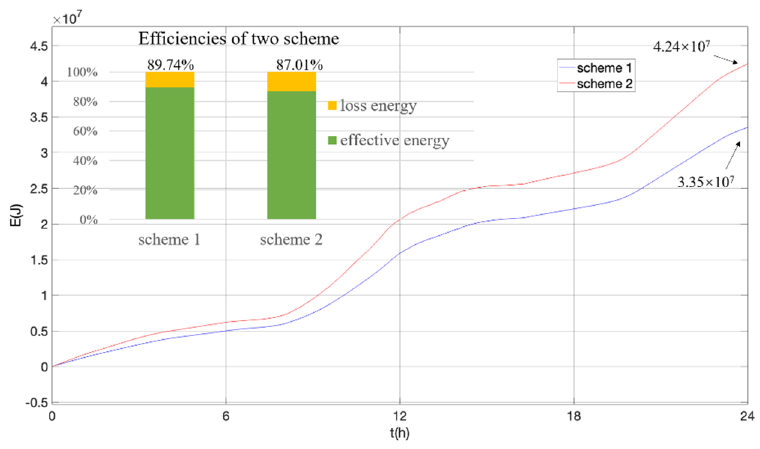
Figure 25. Comparison of energy loss.